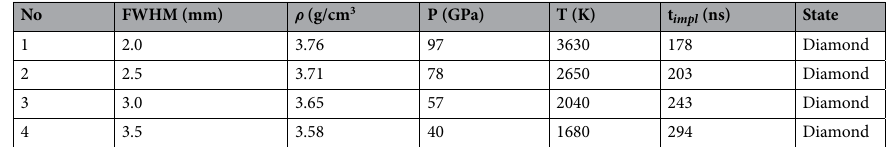
Table 10. Achieved physical conditions in compressed carbon using bunch intensity = 10 11 uranium ions, bunch length = 200 ns, particle energy = 2 GeV/u, initial sample radius, R si = 200 μm, sample mass = 2.8 mg/ cm.